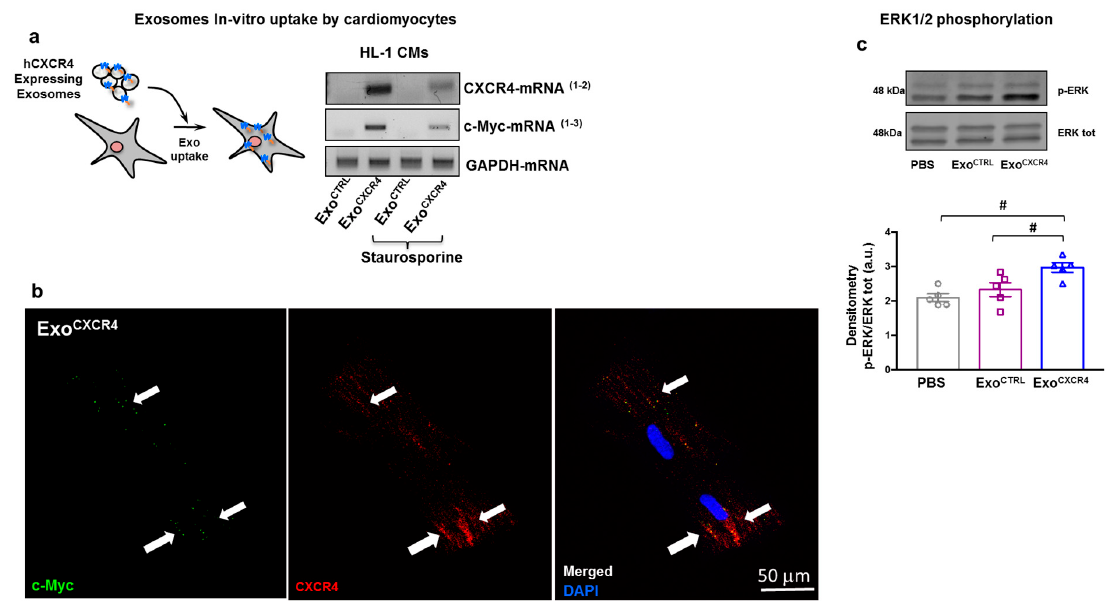
Figure A4. In vitro transfer of CXCR4 mRNA and protein into target cells. ( a ) The c-Myc-mRNA sequence is transferred by Exo into target cells in both physiological and stress conditions (staurosporine). ( b ) Immunofluorescence staining showing the presence of c-Myc-tag protein (white arrows) into adult CM isolated from heart perfused ex vivo with Exo CXCR4cellmiR39 . For the wild-type CXCR4, protein cells have been stained with a primary anti-CXCR4 antibody, which recognizes human and rat protein. ( c ) Phosphorylation of ERK1/2 is enhanced in HL-1 CM after treatment with Exo CXCR4 ( n = 5 patients/group for Exo CTRL and Exo CXCR4 ; n = 5 repeated measurements for PBS ) # p < 0.05 (one-way analyses of variance-ANOVA with post-hoc multiple comparisons using the Tukey-Kramer multiple comparisons test for paired parametric comparisons).